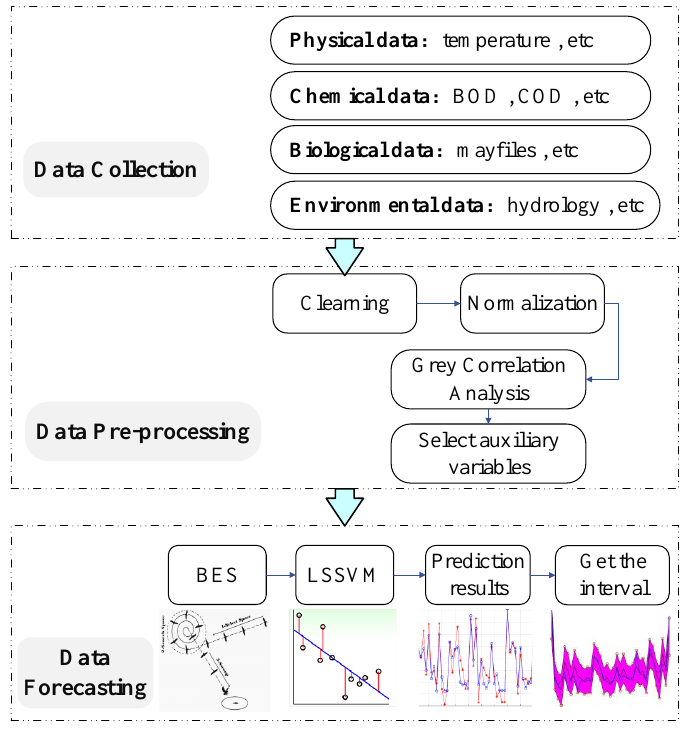
Figure 1. Main steps of the proposed